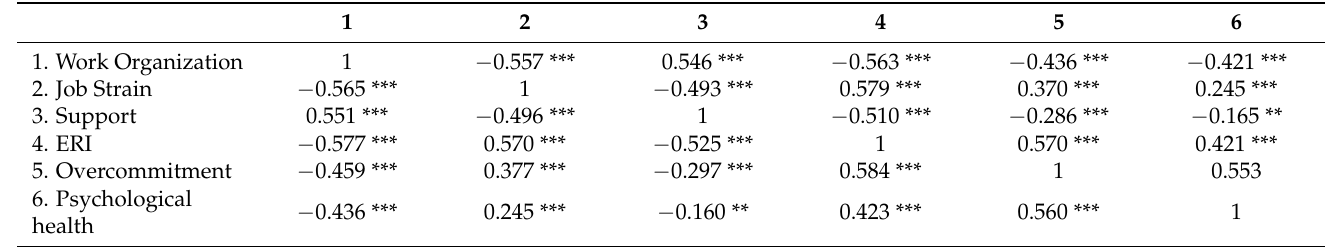
Table 3. Correlations between work organization quality, job strain, effort/reward imbalance, support, overcommitment, and psychological health. Values in the lower triangle are zero-order correlations; values in the upper triangle are partial correlations after controlling for gender and